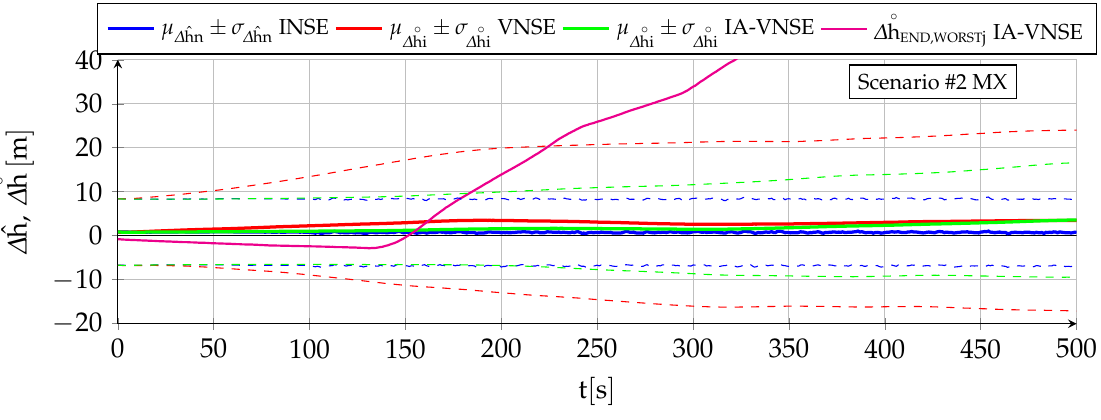
Figure 12. Vertical position INSE, VNSE, and IA-VNSE for scenario #2 MX (100 runs).